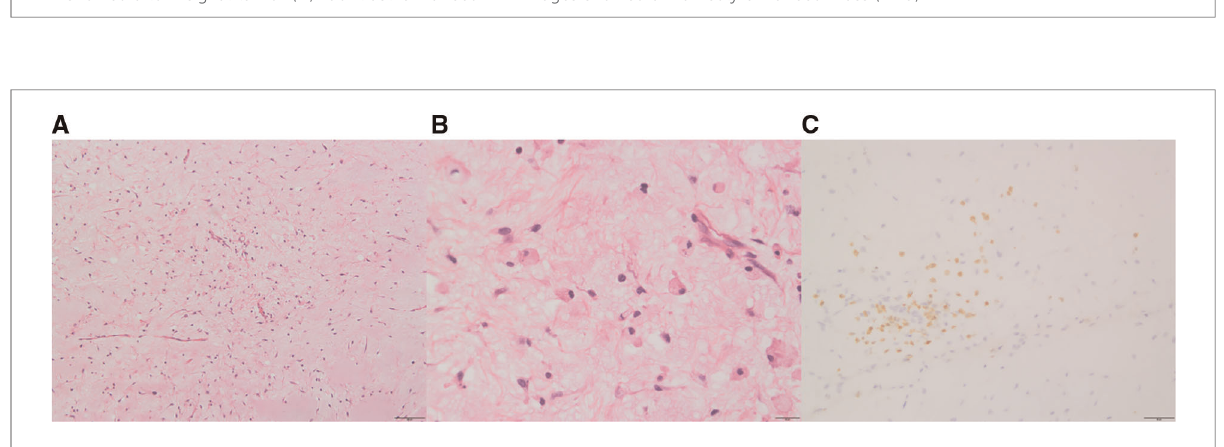
FIGURE 1 At the fi rst illness, on T1-weighted and T2-weighted images, the tumor revealed long signal abnormal signals ( A,B ). In FLAIR, it was an iso-low signal ( C ). DWI showed a low-signal tumor ( D ). Contrast-enhanced MRI images showed a markedly enhanced mass ( E – G ).